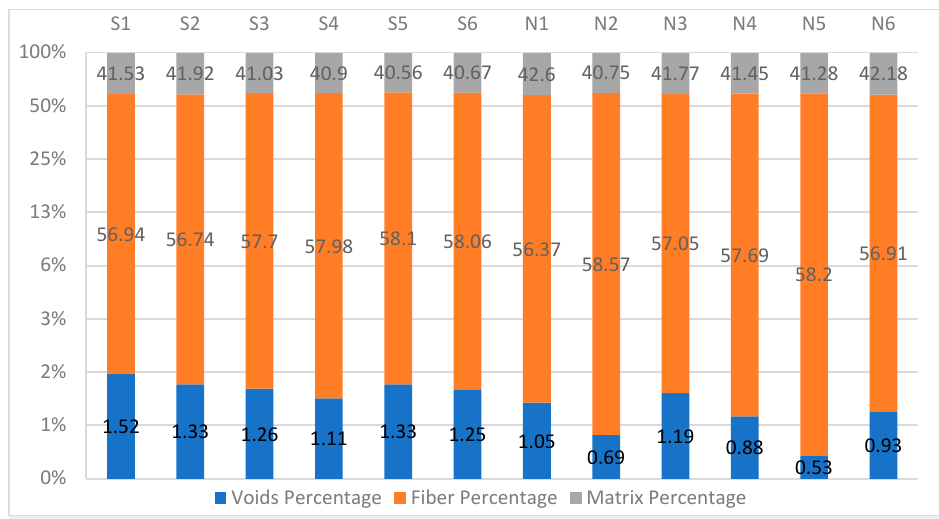
Figure 6. Volume constituent content by acid digestion with a logarithmic scale.